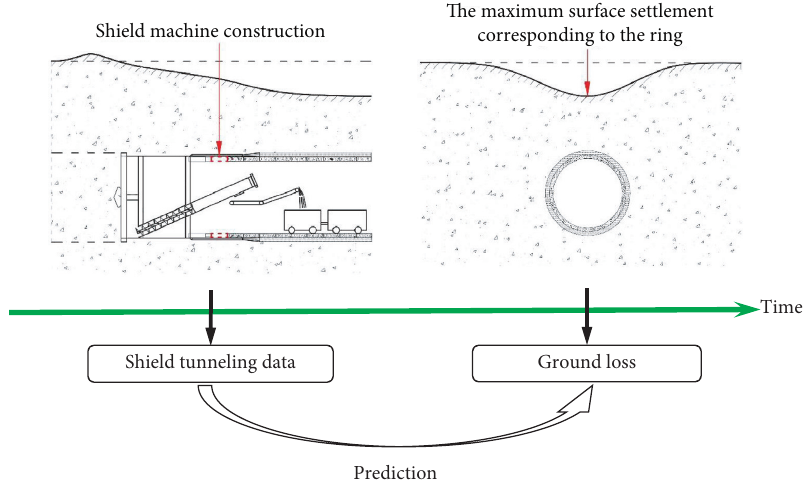
Figure 1: Prediction based on shield construction data.